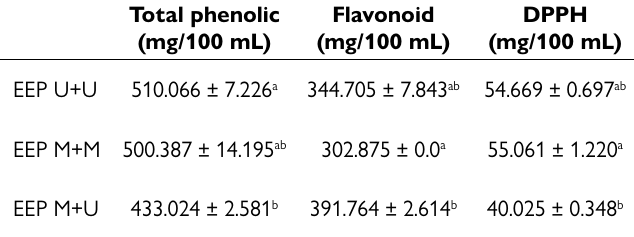
Table 1. Chemical characterization of ethanolic extracts of propolis (total phenolic, flavonoid and antioxidant activity by DPPH).